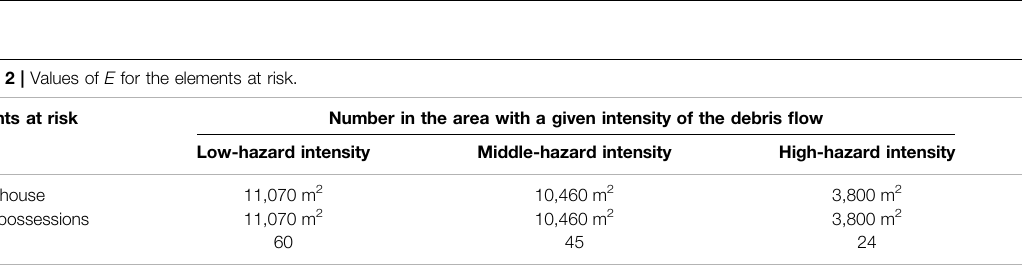
FIGURE 7 | Social risk criteria for the debris fl ow [according to Hong Kong Geotechnical Engineering Of fi ce (1998)].